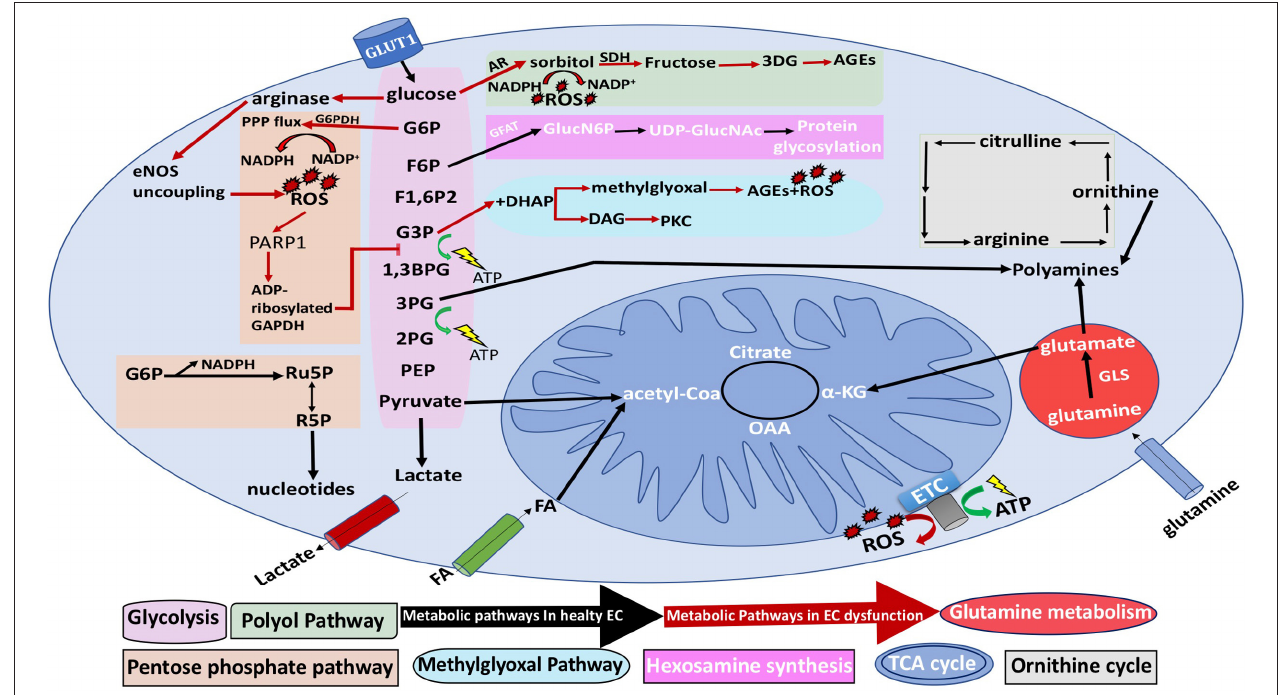
FIGURE 8 | General EC metabolism and the metabolic pathways associated with EC dysfunction. Black arrows represent normal EC metabolic processes, while red arrows represent EC dysfunction. NO, nitric oxide; 3PG, 3-phosphogylcerate; 1,3BPG, 1,3-bisphosphoglycerate acid; α -KG, α -ketoglutarate; CoA, coenzyme A; ETC, electron transport chain; F1,6P2, fructose-1,6-bisphosphate; F2,6P2, fructose-2,6-bisphosphate; F6P, fructose-6-phosphate; FA, fatty acid; G3P, glyceraldehyde-3-phosphate; 2PG, 2-phosphoglyceric acid; PEP, phosphoenolpyruvate G6P, glucose-6-phosphate; GLS, glutaminase; GSH, reduced glutathione; NADPH, nicotinamide adenine dinucleotide phosphate; R5P, ribose-5-phosphate; ROS, reactive oxygen species; PARP1, polyADP-ribose polymerase 1; Ru5P, ribulose-5-phosphate; TCA, tricarboxylic acid; and UDP-GlucNAc, uridine diphosphate N -acetylglucosamine; AR, aldose reductase; eNOS, endothelial nitric oxide synthase; G6PDH, glucose-6-phosphate dehydrogenase; GFAT, glutamine fructose-6-phosphate amidotransferase; GlucN6P, glucosamine-6-phosphate; PKC, protein kinase C; SDH, sorbitol dehydrogenase; OAA,